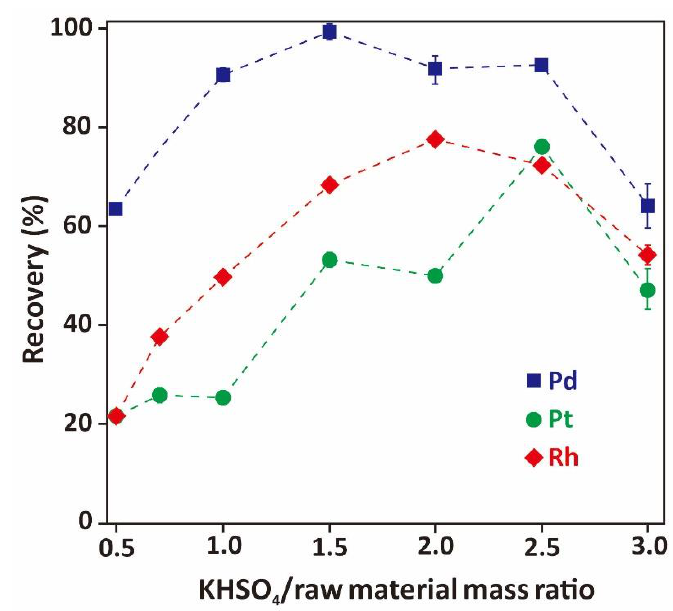
Figure 5. The e ff ect of fusion agent / catalytic converters mass ratios to PGE recovery.